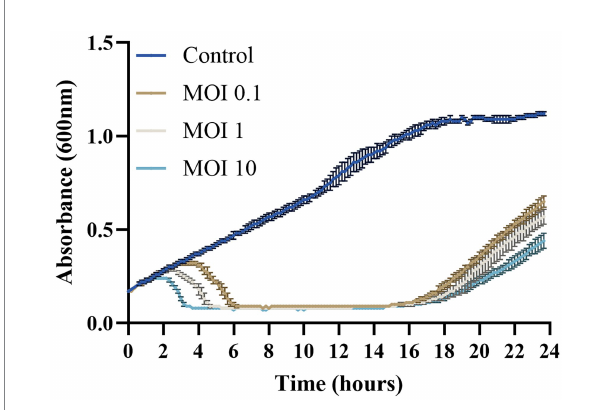
FIGURE 9 In vitro cell lysis assay of Tenacibaculum phage Larrie against host strain LAR25 at three different MOIs (0.1, 1, and 10). Values are mean ± SD ( n =